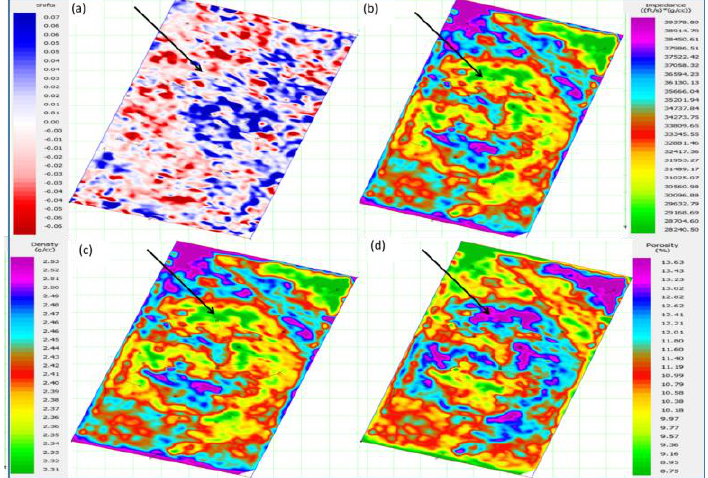
Figure 9. Reservoir horizon slice. ( a ) DV velocity variation between baseline and monitor survey: ( b ) P impedance of seismic monitor survey: ( c ) monitor-predicted density, and ( d ) monitor-predicted porosity. The decrease in DV, impedance, and density and the increase in porosity are indicated by the black